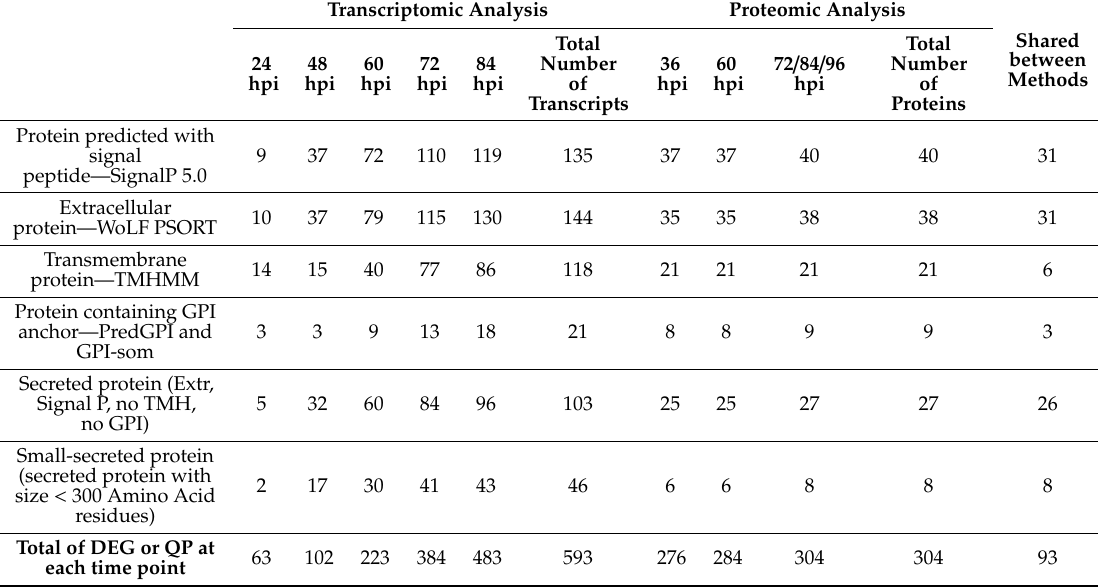
Shared between Methods24